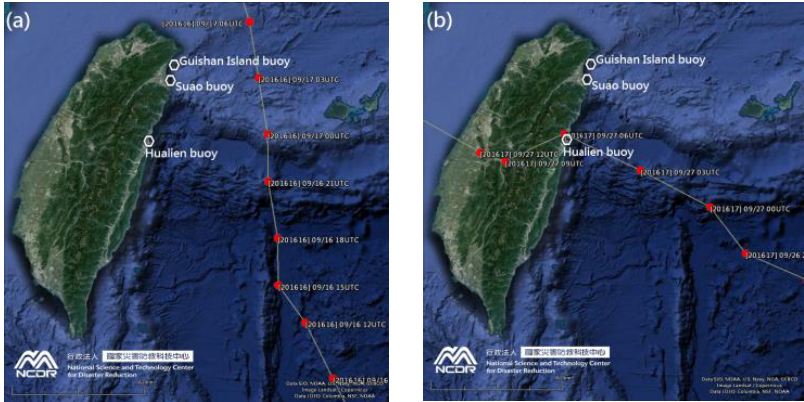
typhoon model. In general, the SWHs generated by the hybrid typhoon model were in greater agreement about observations in the peak and normal phases.